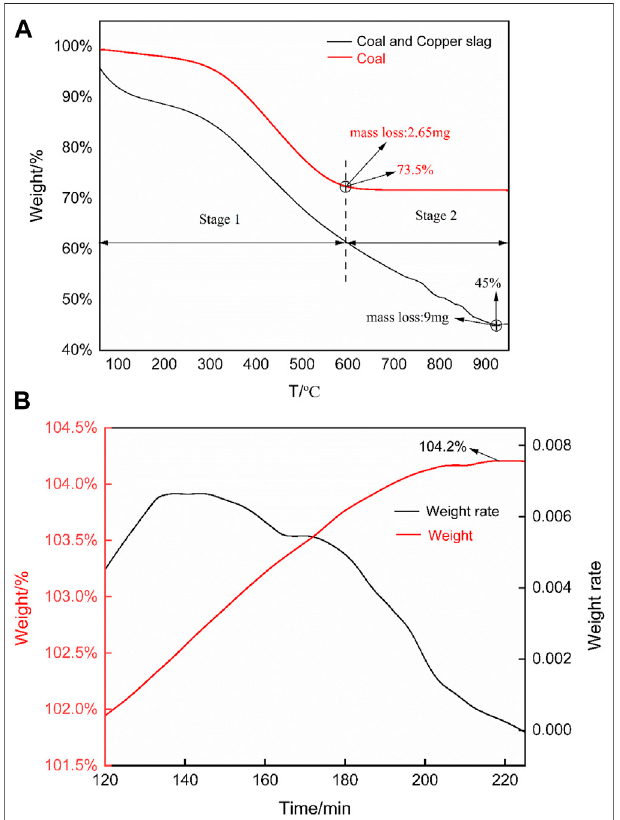
FIGURE4| TGcurvesofoxygenreleaseandabsorption. (A) TGcurveof oxygen release. (B) TG curve of oxygen absorption.